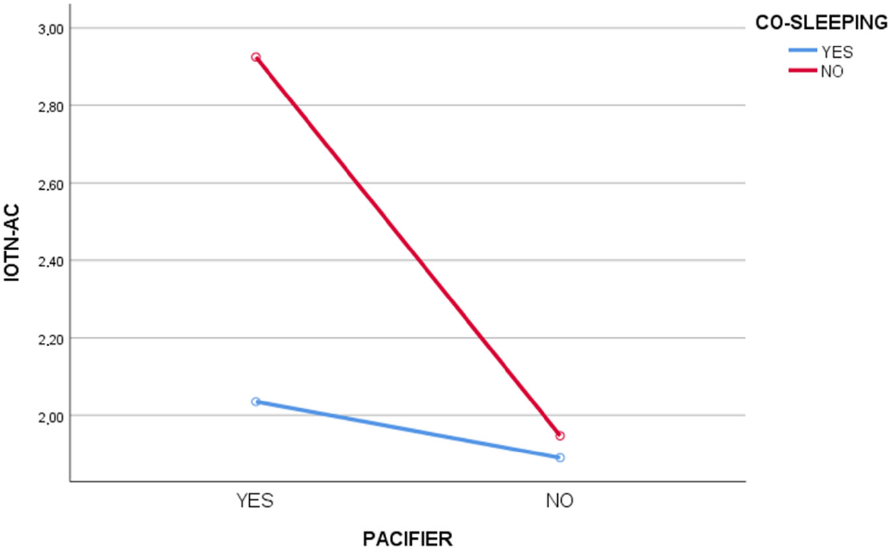
Figure 1. Two-way ANOVA for the variables of co-sleeping (yes/no) and pacifier (yes/no) on IOTN-AC. The same occurred for digital sucking, co-sleeping and the IOTN-AC (F(1,217) = 3.96; p = 0.048; η 2 = 0.018) (see Figure 2).